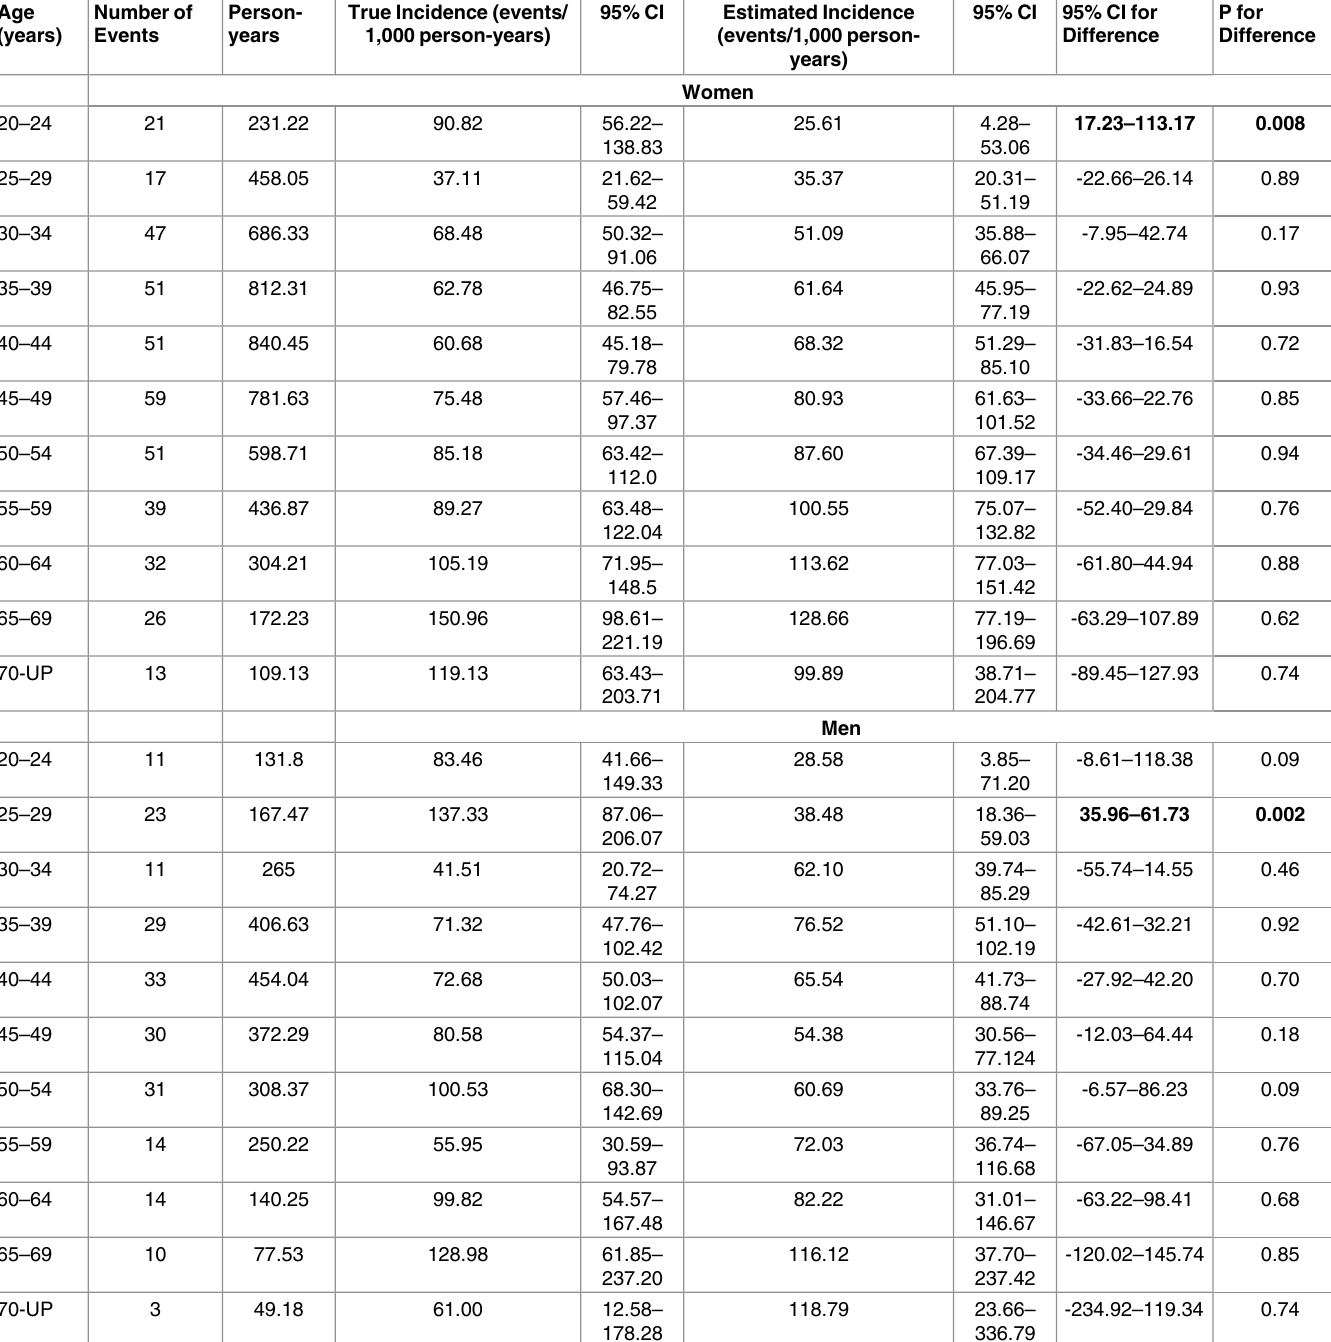
Table 2. Age- and sex-specificobserved (true) and estimated incidence rate of chronic kidney disease in the cohort with type 2 diabetes during the study period (1982–2007). CI, confidenceinterval. Age